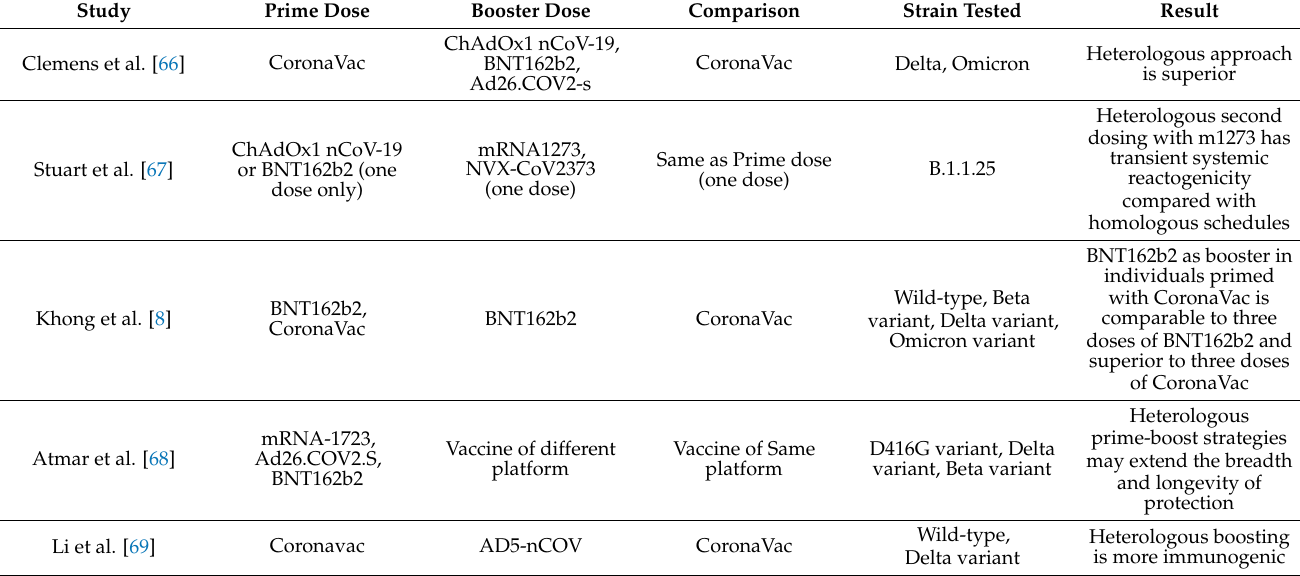
Table 1. Immunogenicity of heterologous vaccine strategy against homologous vaccine